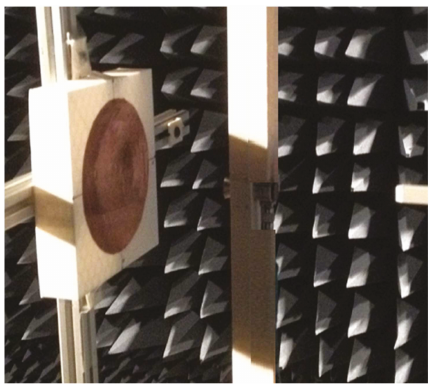
Figure 8: A picture of the fabricated 3D printed re fl ector antenna.